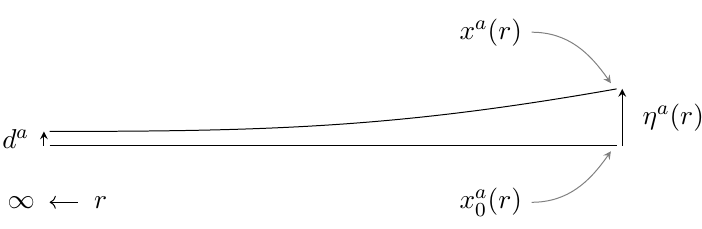
Figure 2 . A light ray generated by n a and a deformed light ray generated by n a deviation between the two light rays at a(cid:14)ne time r is denoted by (cid:17) a ( r